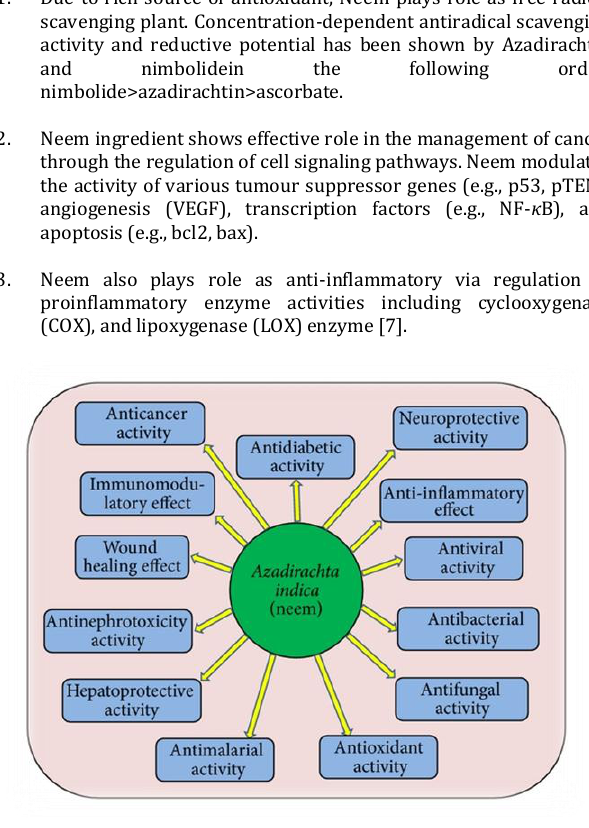
Figure 5: Different pharmacological activities of